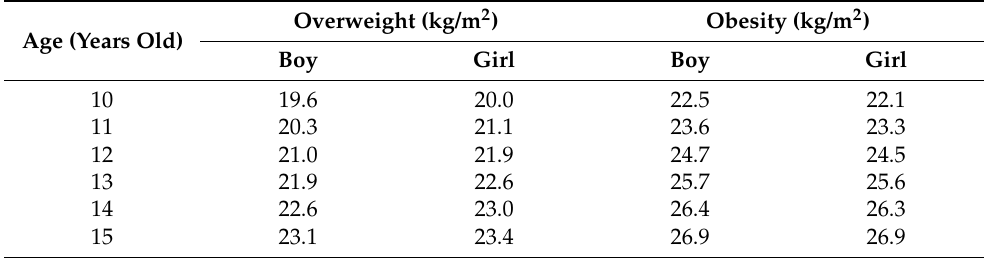
Table 1. Screening for overweight and obesity among school-age children and children.